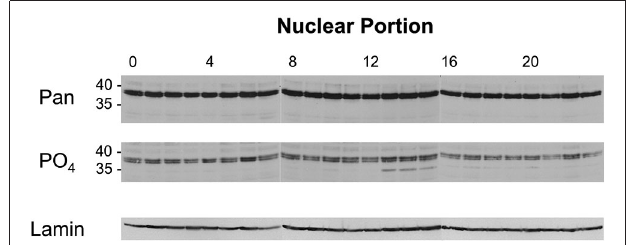
FIGURE 6 | Levels of cytoplasmic dCREB2 protein isoforms oscillate through the day/night. Representative Western blot images of cytoplasmic dCREB2 isoforms show oscillation within a 24-h period. After entraining to a 12-12 light-dark schedule, wild-type animals were collected at the beginning of each hour throughout the day, heads were separated, and cytoplasmic protein was isolated for each sample. Samples were analyzed using SDS-PAGE and Western blot and were probed with HSP-70 as a loading control. To analyze dCREB2 isoform levels across the day, cytoplasmic samples were probed with an α -Pan (top) and α -PO 4 (middle)